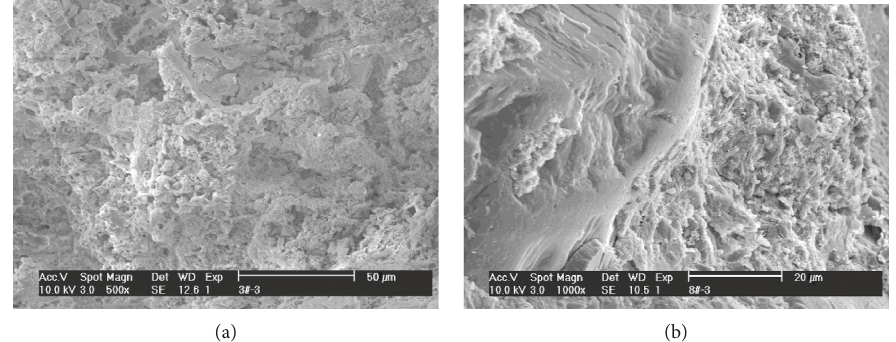
Figure 5: Effect of the polymer latex on the hydraulic products (SEM photos). (a) Specimens without polymer latex. (b) Specimens with polymer latex.